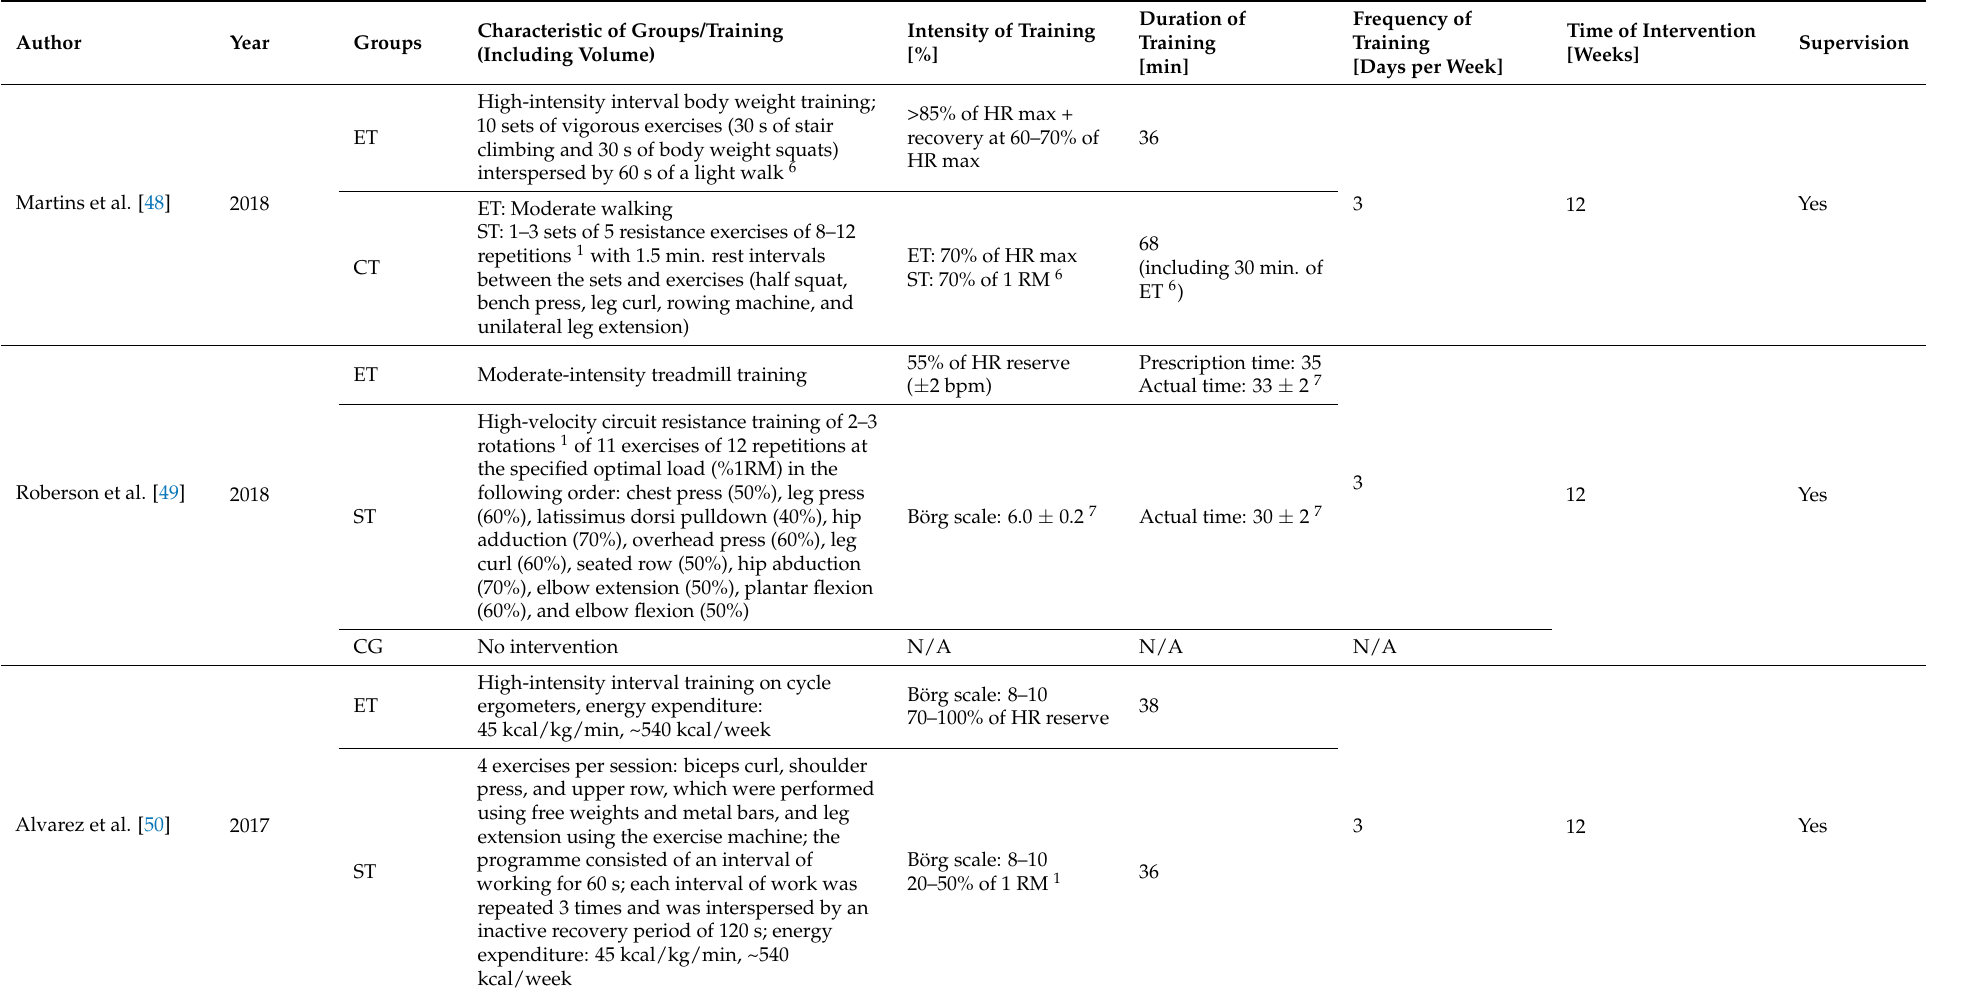
4 exercises per session: biceps curl, shoulder press, and upper row, which were